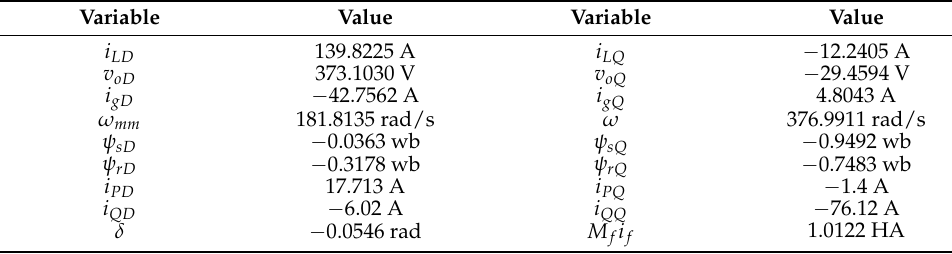
Table 3. Equilibrium point for the synchronverter test